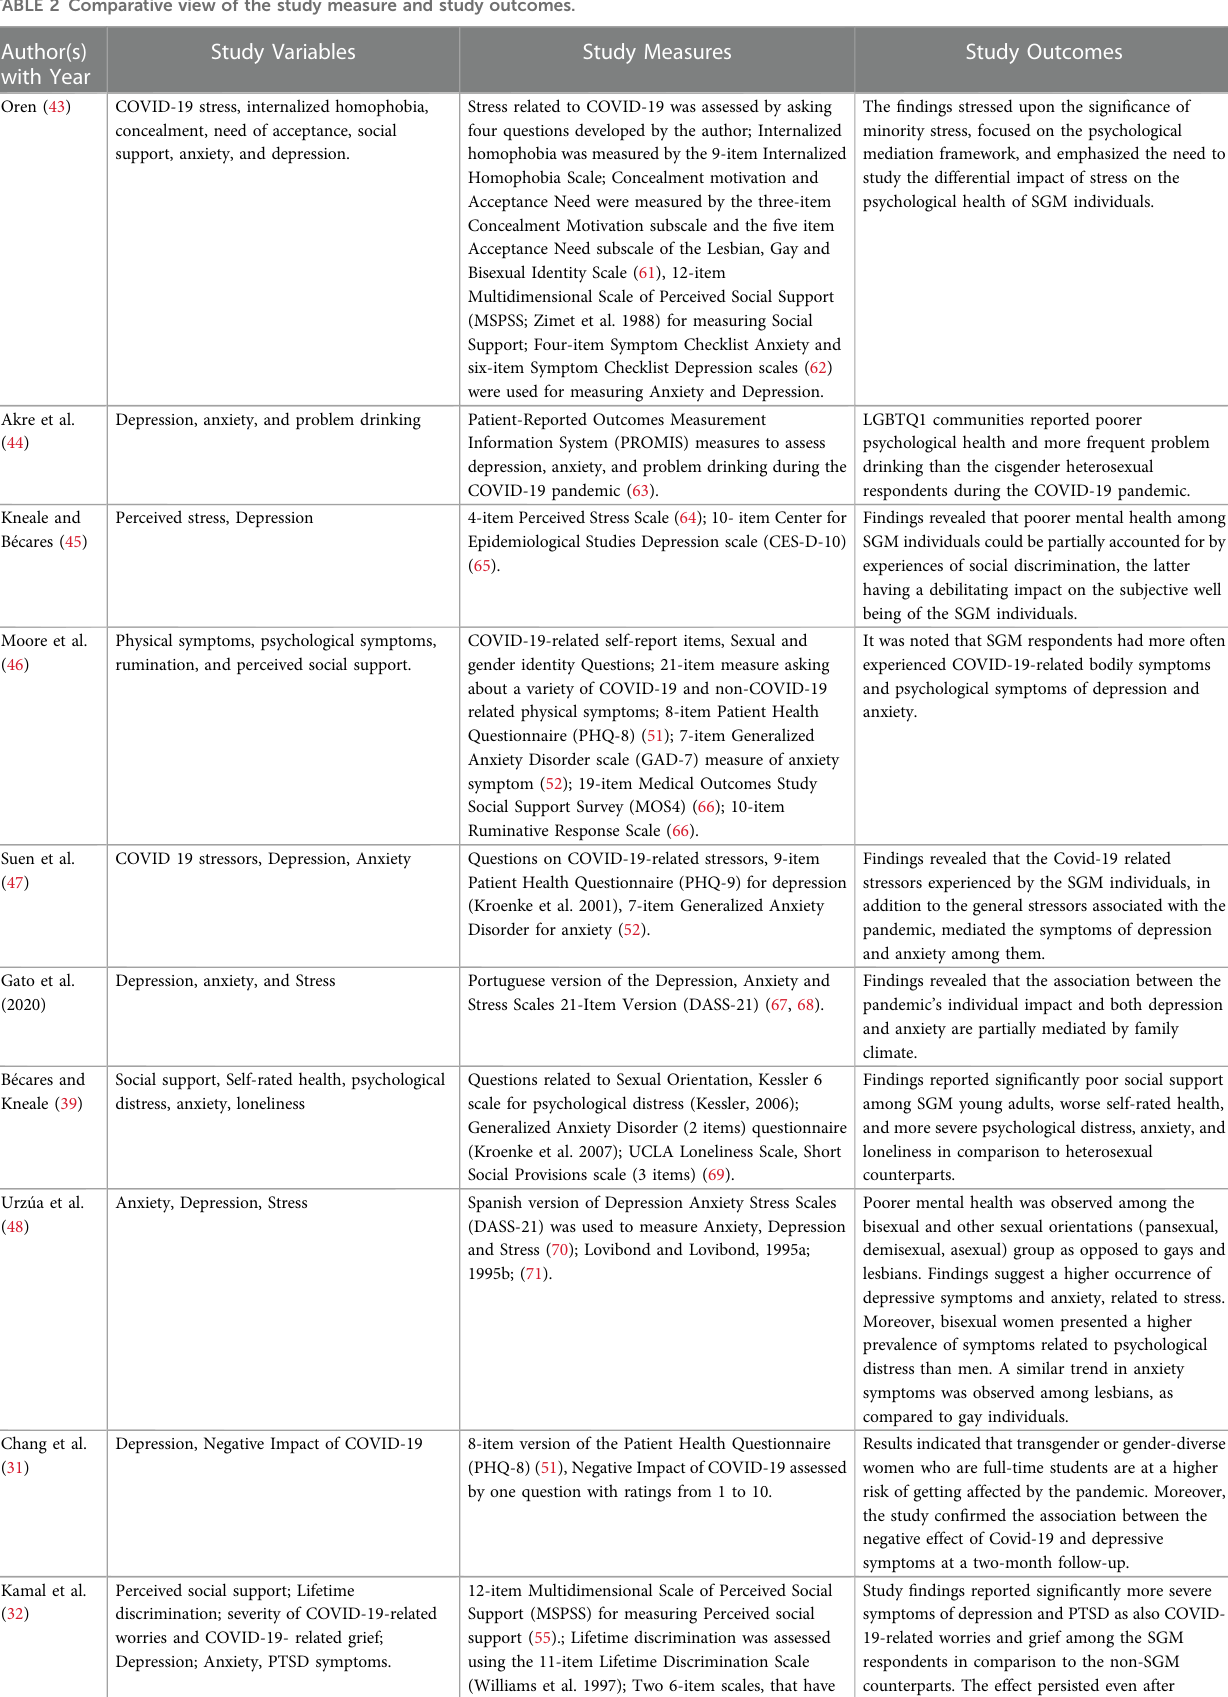
TABLE 2 Comparative view of the study measure and study